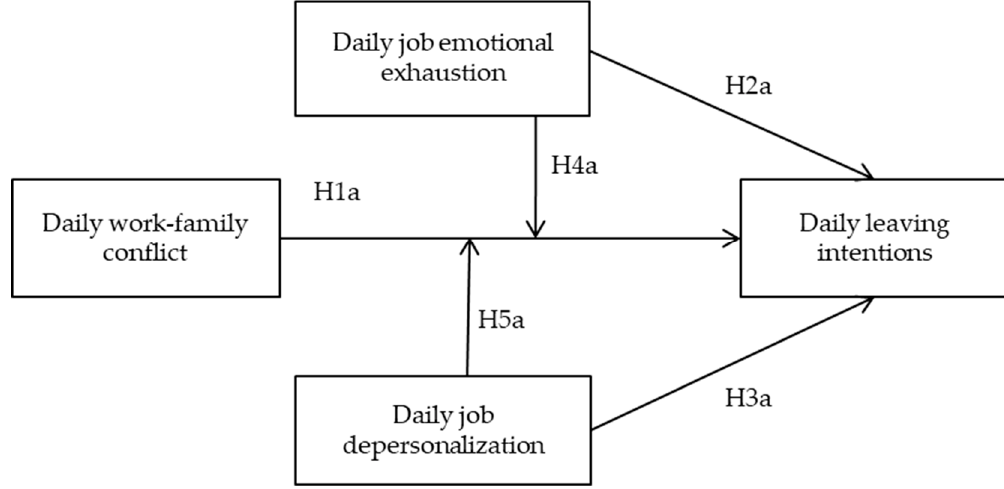
Figure 1. Research model and hypotheses to explain daily leaving intentions.